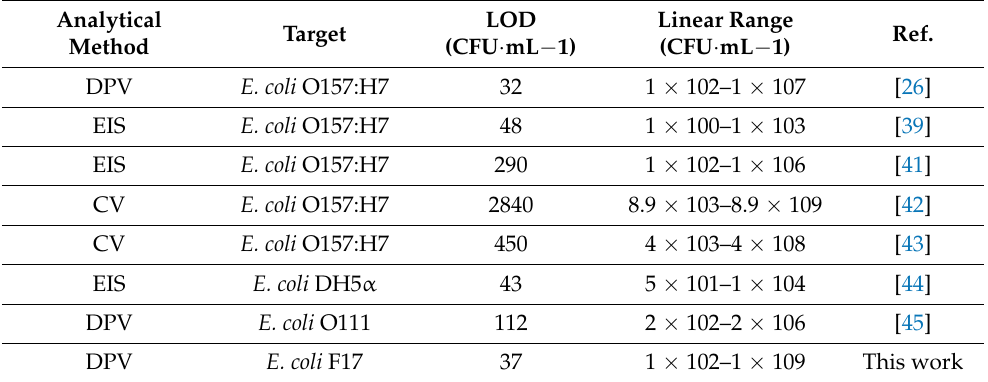
Table 1. Comparison of the prepared sensor performances with other electrochemical sensors, reported in literature, used for pathogenic E. coli